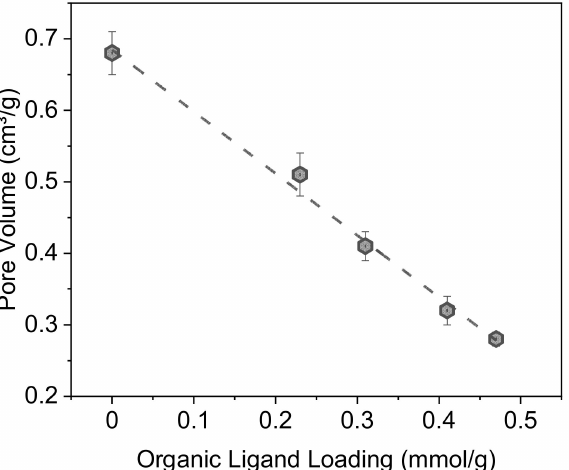
Figure 5. Residual pore volume in the pre-functionalized support and the impregnated materials as a function of the concentration of organic ligand (DEHCEBP) in the